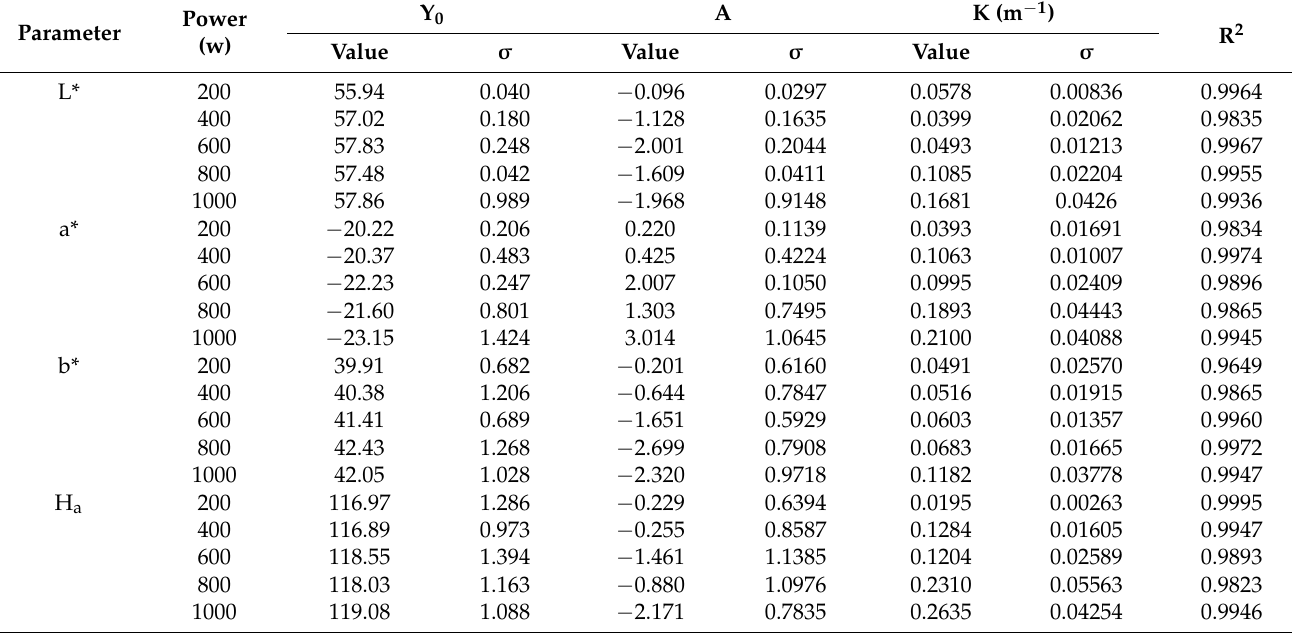
Table 1. The estimated kinetic parameters and the statistical values of kinetic models for L*, a*, b*, and Hue angle (H a ) for various microwave output powers. Y – Y 0 = A